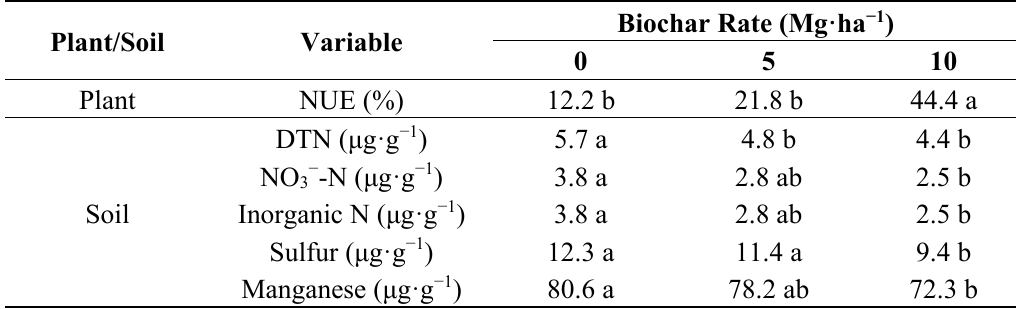
Table 5. Mean nitrogen uptake efficiency (NUE) in corn and soil dissolved total N (DTN), nitrate (NO 3 − -N), inorganic N, and Mehlich-3 extractable soil sulfur and manganese concentrations as affected by biochar